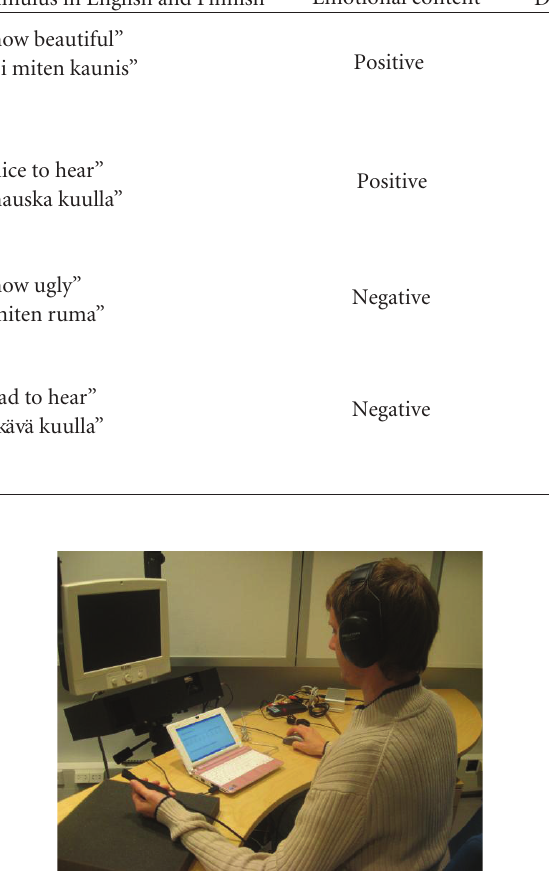
Figure 2: Picture of the experimental